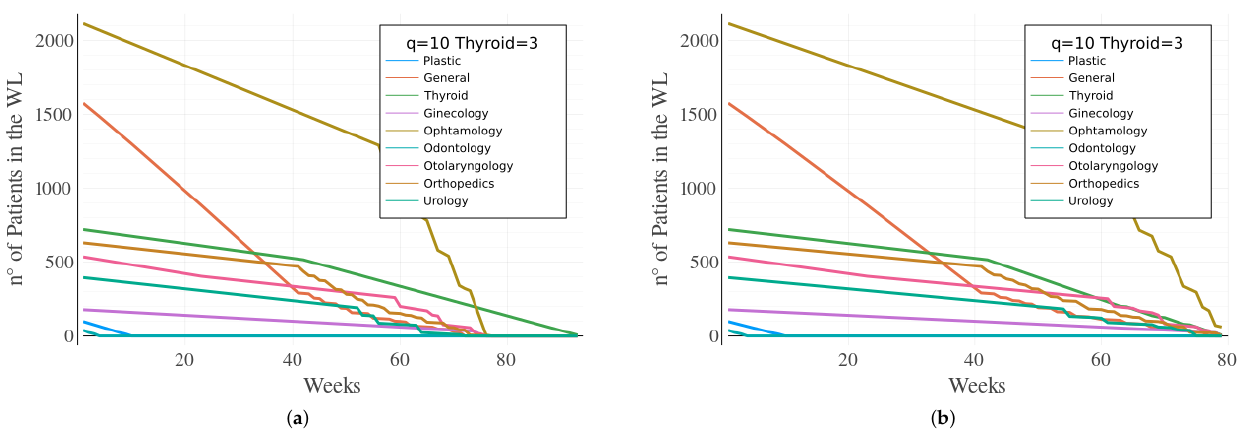
Figure 5. Patients in the waiting list per week with ( a ) Thyroid = 2 and ( b ) Thyroid =